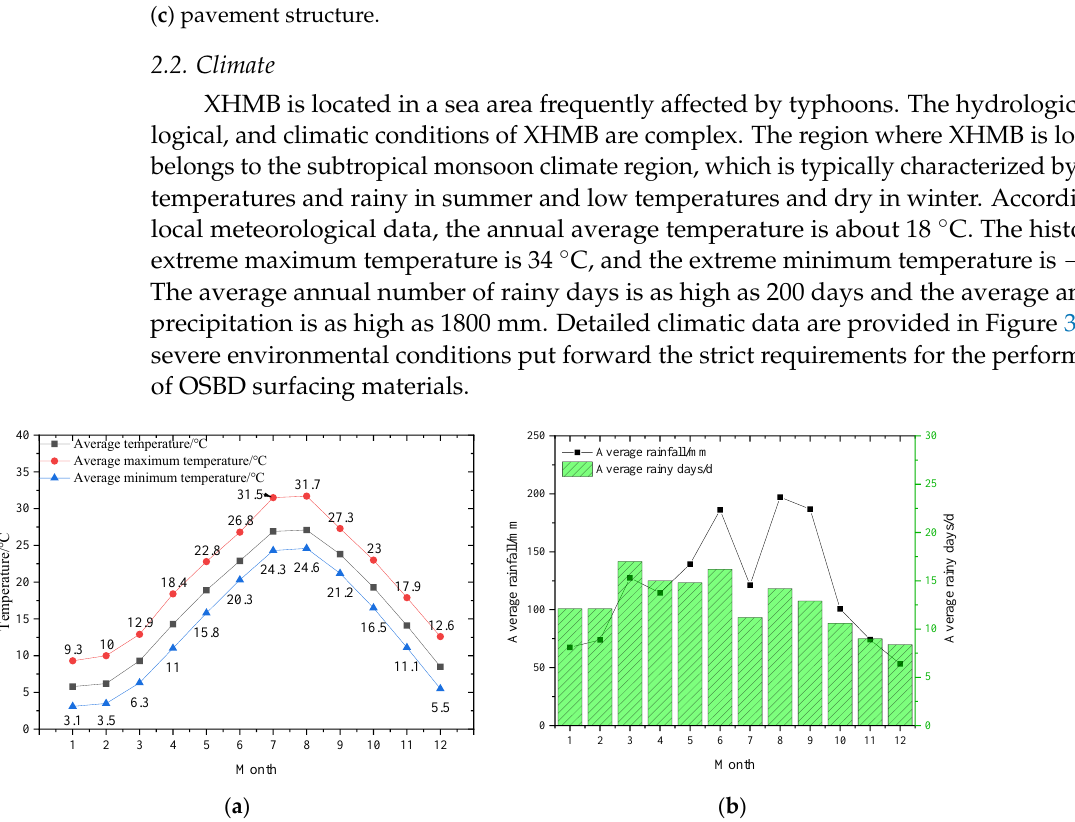
( b ) Figure 3. Climatic information for XHMB: ( a ) temperature; ( b ) rainfall.